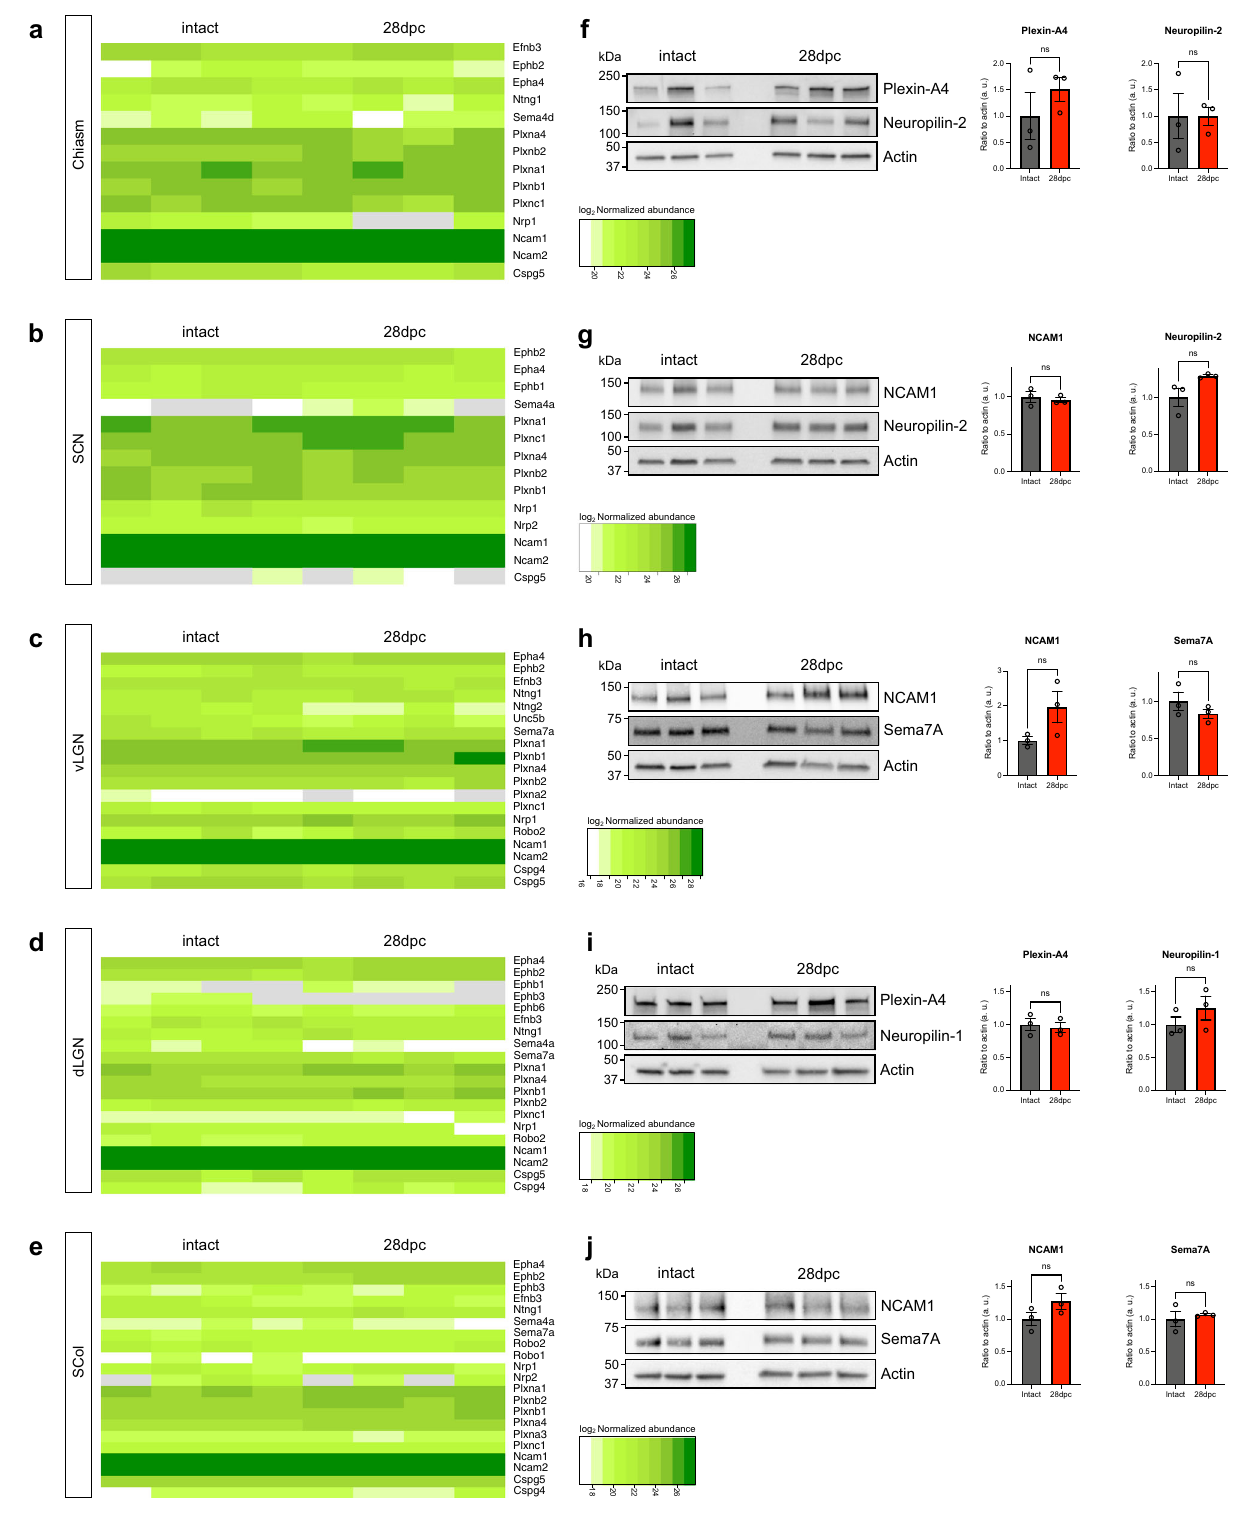
Fig.4|Expressionofguidanceandguidance-associatedfactorsremainssteady intheadultbrainvisualtargetsafteropticnerveinjury.a – e Heatmapsshowing proteinexpressionlevels(log 2 Normalizedabundance)inallreplicatesofintactand injured (crush) conditions. f – j Western blot analysis of selected proteins on inde- pendent biological replicates of each visual targets (left) and corresponding